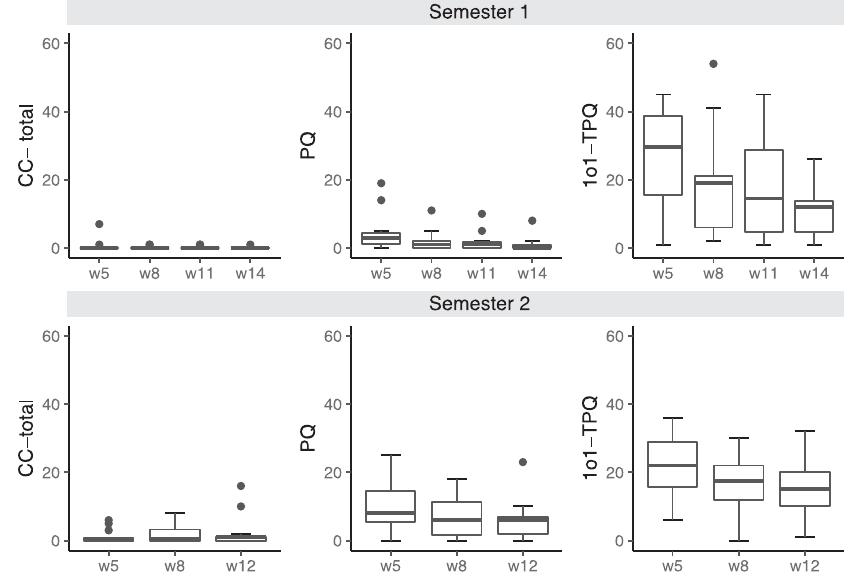
FIG. 7. Frequencies of questioning-related skills over the course of semester 1 and semester 2, respectively. In semester 1, each GTA was observed four times, and the average frequencies of both PQ and 1o1-TPQ were lower in week 14 compared to week 5. In semester 2, each GTA was observed three times, and PQ had a lower average frequency in week 12 compared to week 5.